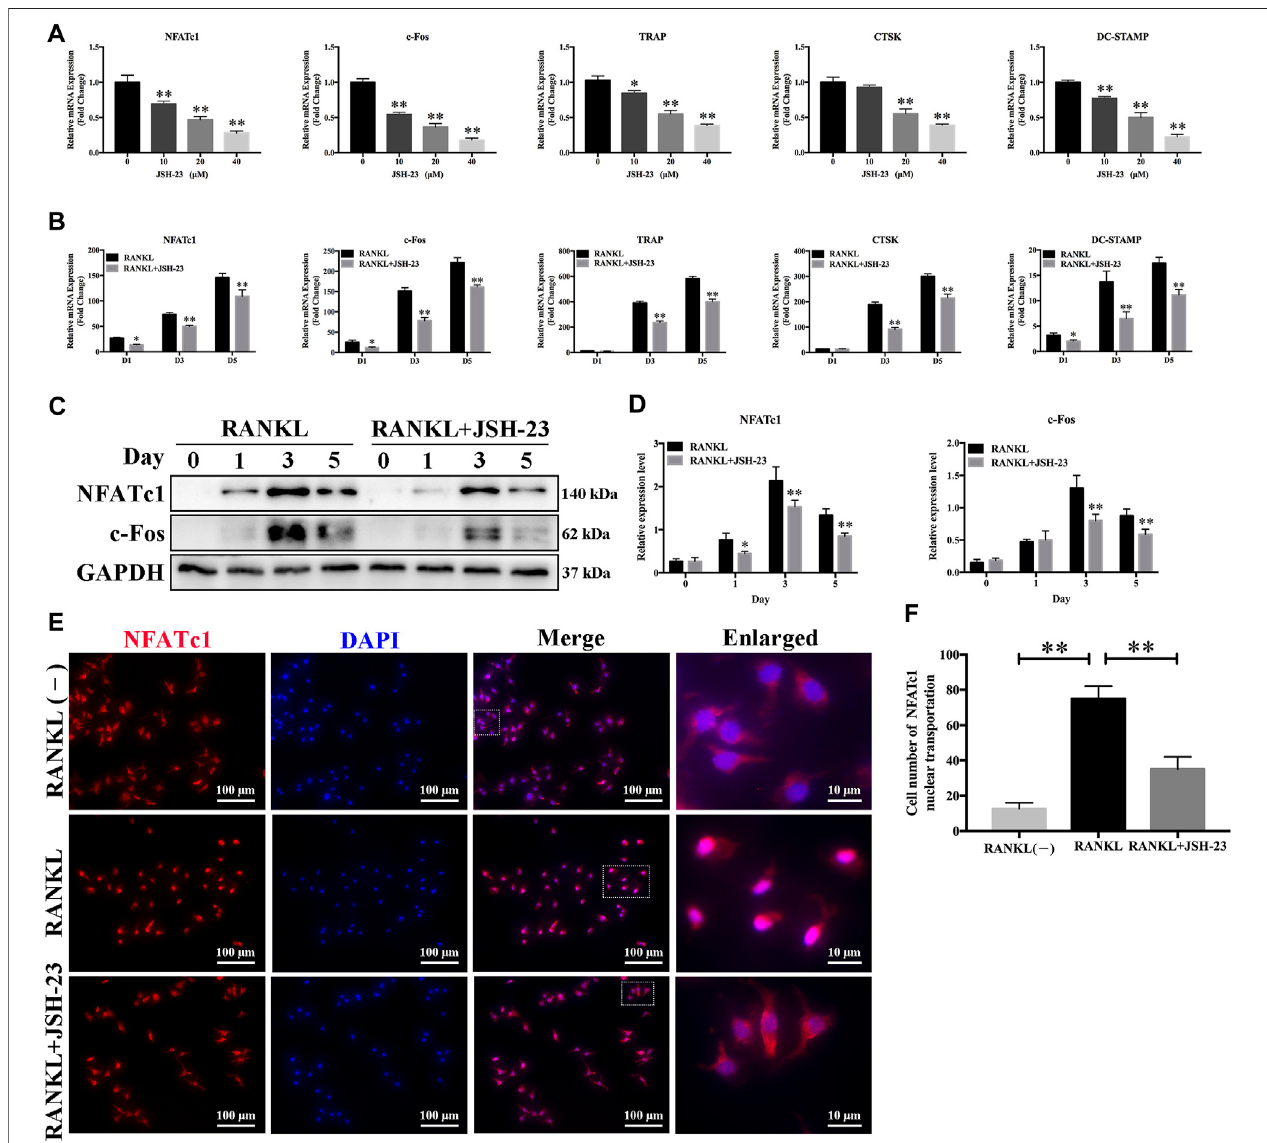
FIGURE2| Osteoclast-speci fi cgeneexpressionisinhibitedbyJSH-23duringosteoclastogenesis. (A) BMMswereculturedtogeneratematureosteoclastsfor5 dayswith differentdosesofJSH-23(10, 20,and 40 μ M). (B) BMMswerestimulatedwithM-CSF and RANKL andtreated with40 μ MJSH-23 at1,3,and 5 days.ThemRNAexpression levelsofNFATc1,c-Fos,TRAP,CTSK,andDC-STAMPweremeasuredbyqPCR. (C) TheproteinexpressionofNfATc1andc-Foswasanalyzedbywesternblotting(days1,3, and 5) and (D) quantitatively analyzed. (E) Immuno fl uorescence analysis of BMMs stimulated with RANKL for 3 days to detect the expression of NFATc1. (F) Quantitative analysis of cells with NFATc1 nuclear translocation using ImageJ. The values are shown as the means ± SDs, n (cid:1) 3; * p < 0.05, ** p < 0.01.